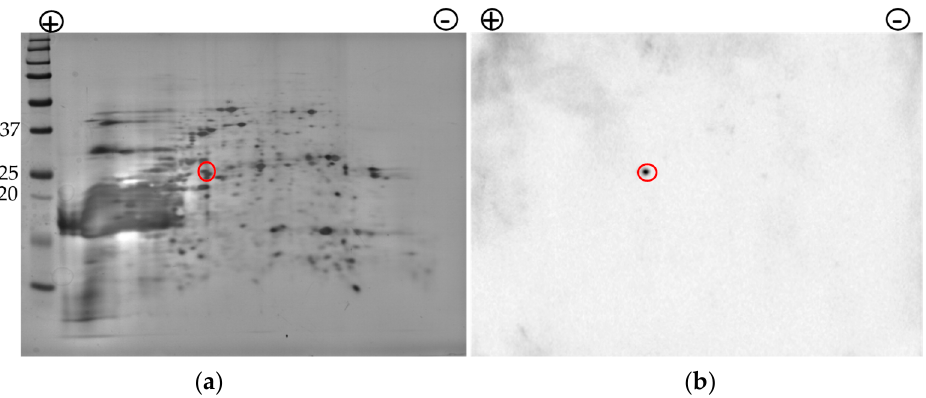
Figure 4. Nrg1p is localized in the cell surface extract of C. auris . ( a ), The silver-stained SDS-PAGE gel image of cell surface proteins after 2-DE. ( b ), Western analysis of the same proteins against rabbit anti- Cal Nrg1 antibody. The antibody reactive Nrg1p spot (marked in a red circle) with a molecular weight of around 26 kDa is shown in panel ( b ). All blue prestained protein standard (Bio-Rad, Hercules, CA, USA) was included in the 2nd dimension gel ( a ). Potential Nrg1p is marked in red circle ( a ).